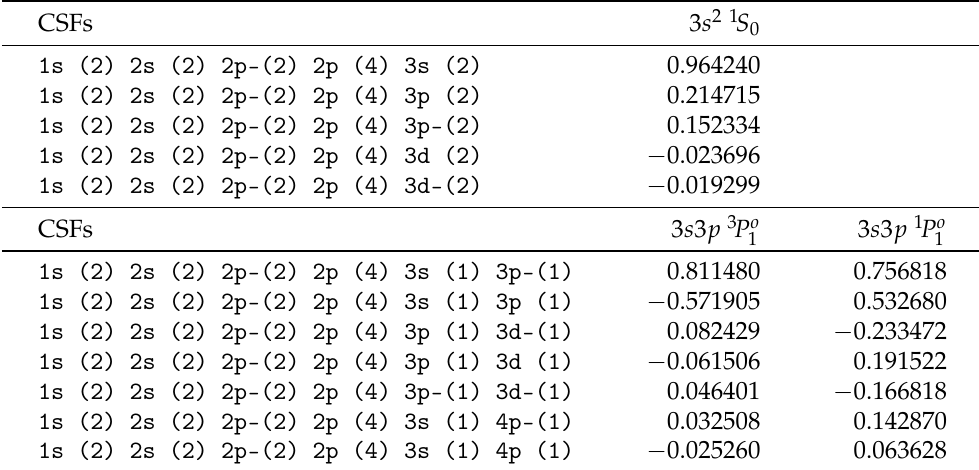
Table 4. CSFs and corresponding expansion coefficients for the MR of the 1 s 2 2 s 2 2 p 6 3 s 2 1 S 0